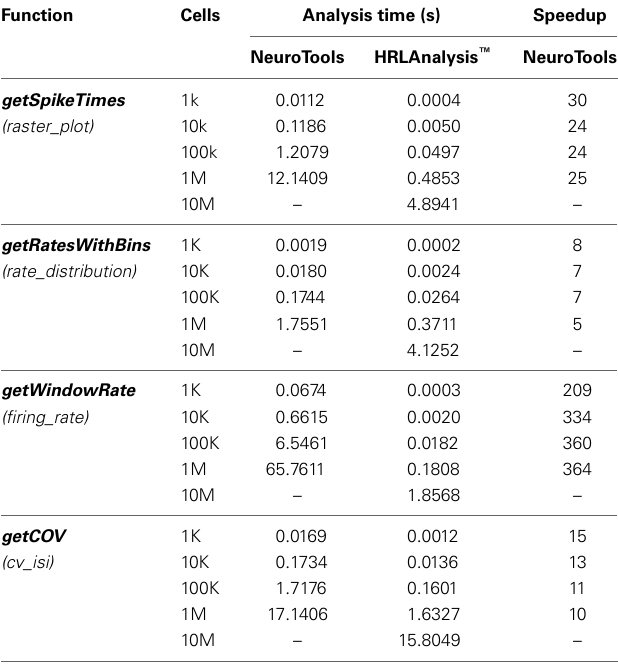
Table 2 | Benchmark results.